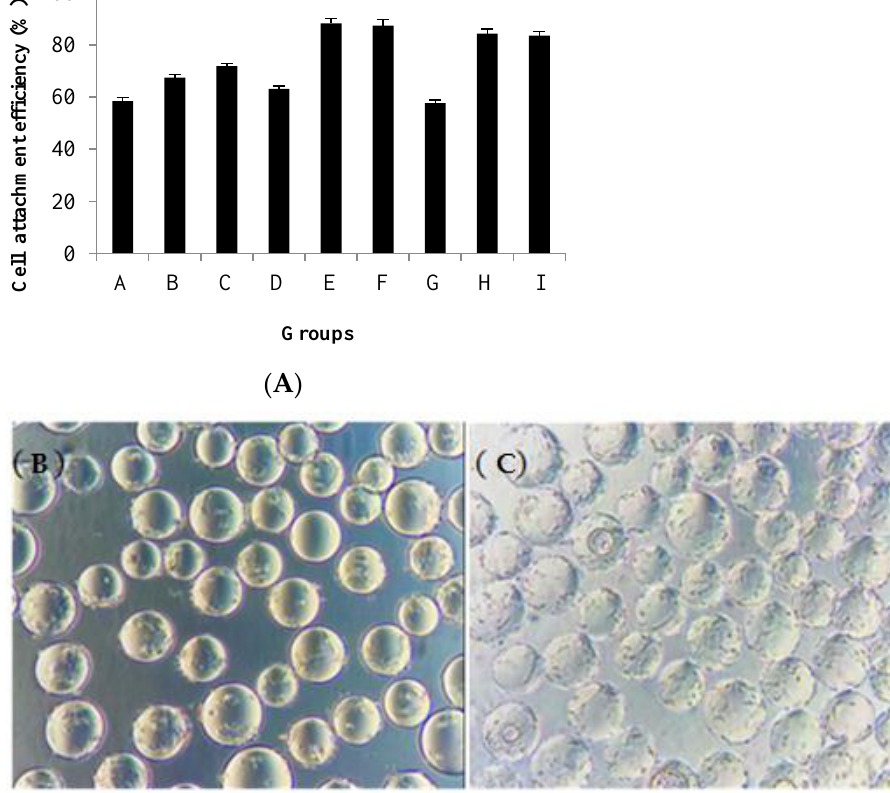
Figure 3. Cell attachment 5 h post inoculation. ( A ) Cell attachment efficiency with different agitation methods (from group A to H). Bars show the mean ± SD, n = 3; ( B , C ) cell attachment status of group H ( B ) and group E ( C ) observed under the phase contrast microscope (10×).